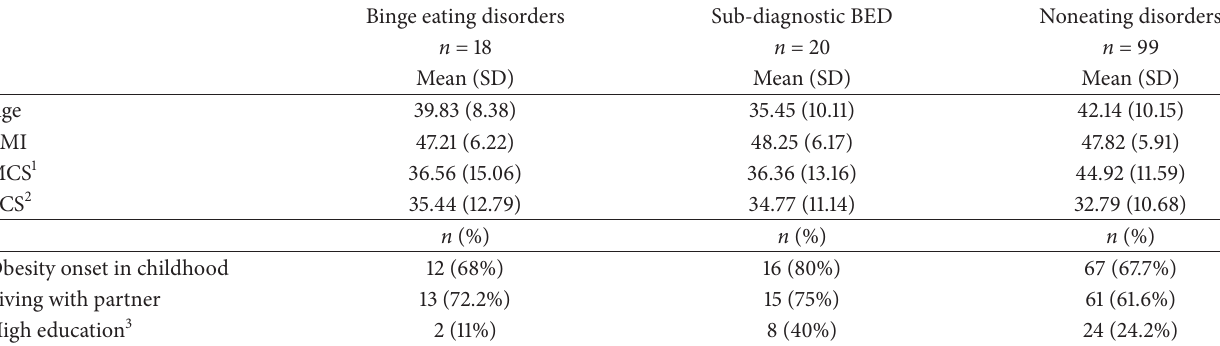
Mental component summary. 2 Physical component